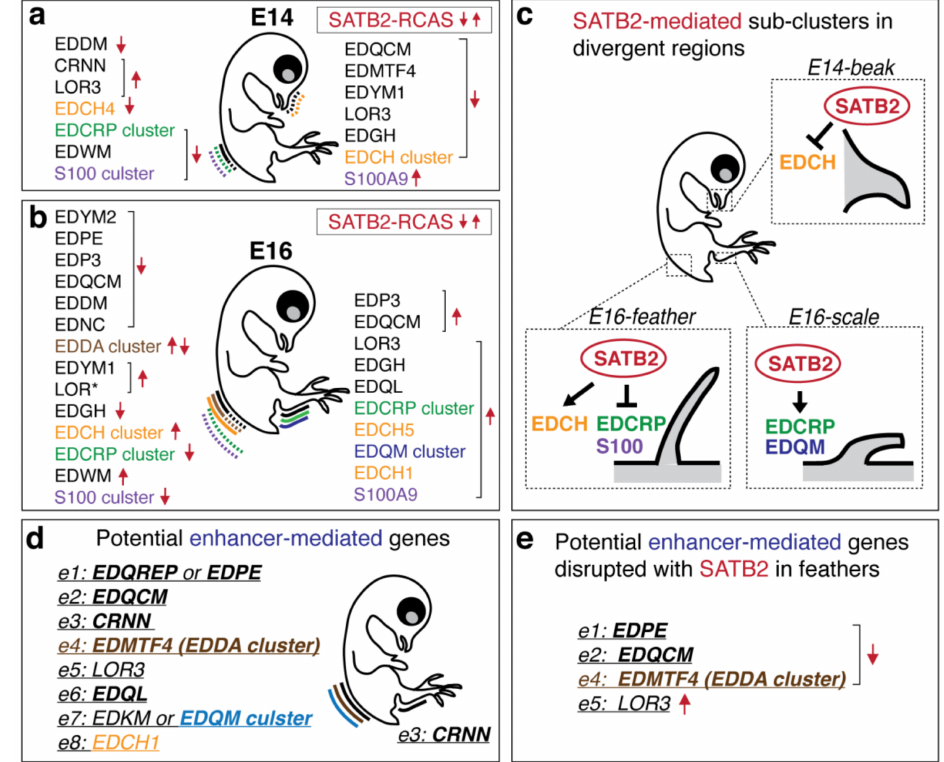
Figure 6. SATB2-mediated or putative enhancer-mediated expression for non- β -keratin EDC genes in different developing integumentary organs. ( a , b ) Summary of non- β -keratin EDC genes or gene clusters in which expression was disrupted under RCAS -SATB2 infection at E14 of feathers and beaks ( a ) or at E16 of feathers and scales ( b ) from Figure 3. Red arrows indicate candidate genes were down- or up- regulated under the SATB2-RCAS infection. ( c ) Summary of SATB2-mediated sub-clusters in divergent regions from ( a ) and ( b ). The opposite regulation of EDC sub-clusters such as EDCRP and EDCH between feathers and scales or feathers and beaks, respectively. ( d ) Summary of non- β -keratin EDC genes with putative enhancers (e1 to e8) in feather or scale regions from Figure 2. Genes in bold indicate their expression level over 500 CPMs in Figure 1. ( e ) Potential genes mediated by both SATB2 and